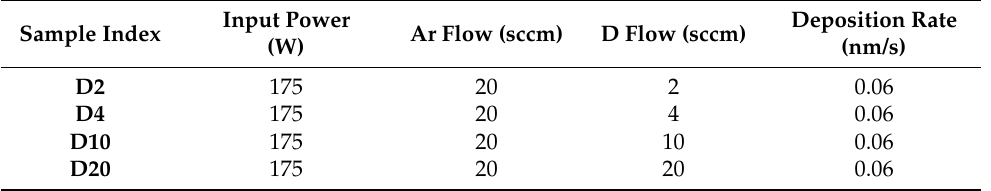
Table 1. The main deposition conditions of the studied Be-D